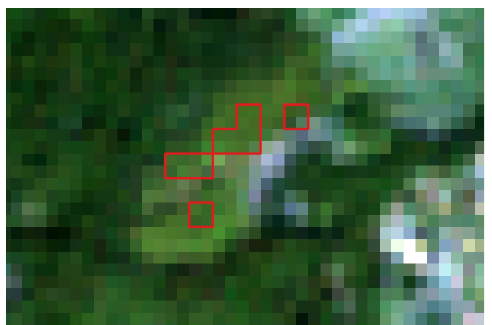
Figure 9 Result of the detection based on the distance between a pixel and the spectral detector obtained with SCP plugin.